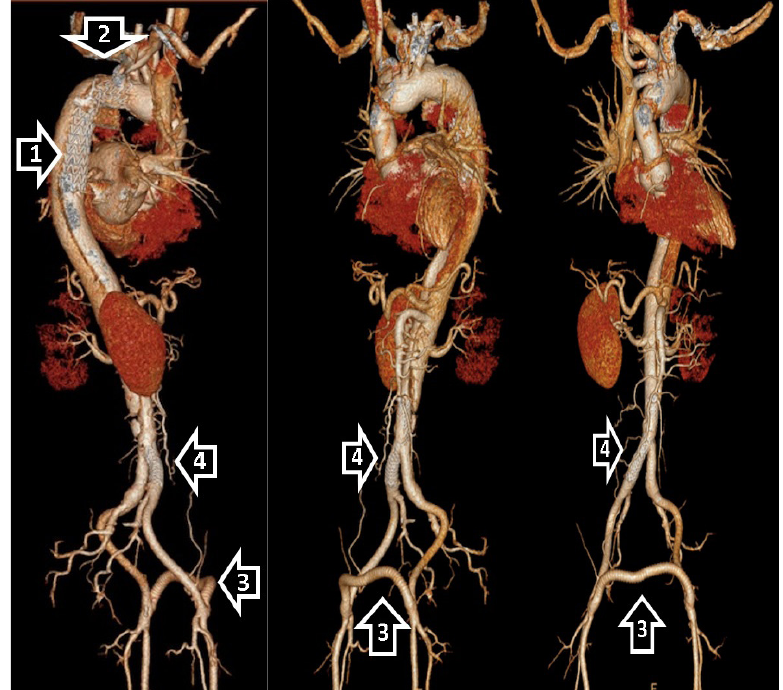
Image. Multiple three-dimensional reconstruction views of computer tomography angiogram of the aorta demonstrating the thoracic endovascular aortic graft (1) into the descending aorta, and an ascending interposition graft (2). Including the left femoral to right femoral bypass graft (3), and right iliac stent